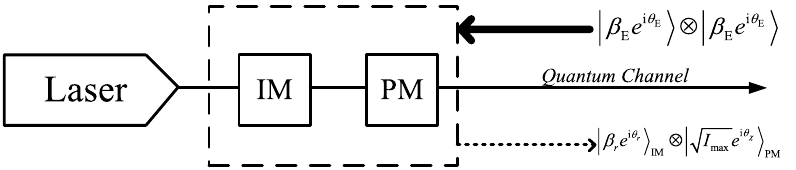
Figure 2. Example of a THA against the IM and the PM of Alice (Bob). For simplicity, we assume that Eve sends Alice (Bob) two high intensity single-mode coherent pulses, each of which is denoted by of them targets the IM and the other one targets the PM. We further assume also for simplicity that the back- reflected light from the IM and the PM to Eve is in a product state of two coherent states. One comes from the β r e i θ r IM, which we denote by , and the other comes from the PM, which has the form (cid:31) (cid:30) and χ refer to the intensity setting and basis choice, respectively, with r (cid:31) partial information about the intensity settings and the basis choices by separately measuring the states √ I max e i θ χ and (cid:31) (cid:30) (cid:31)